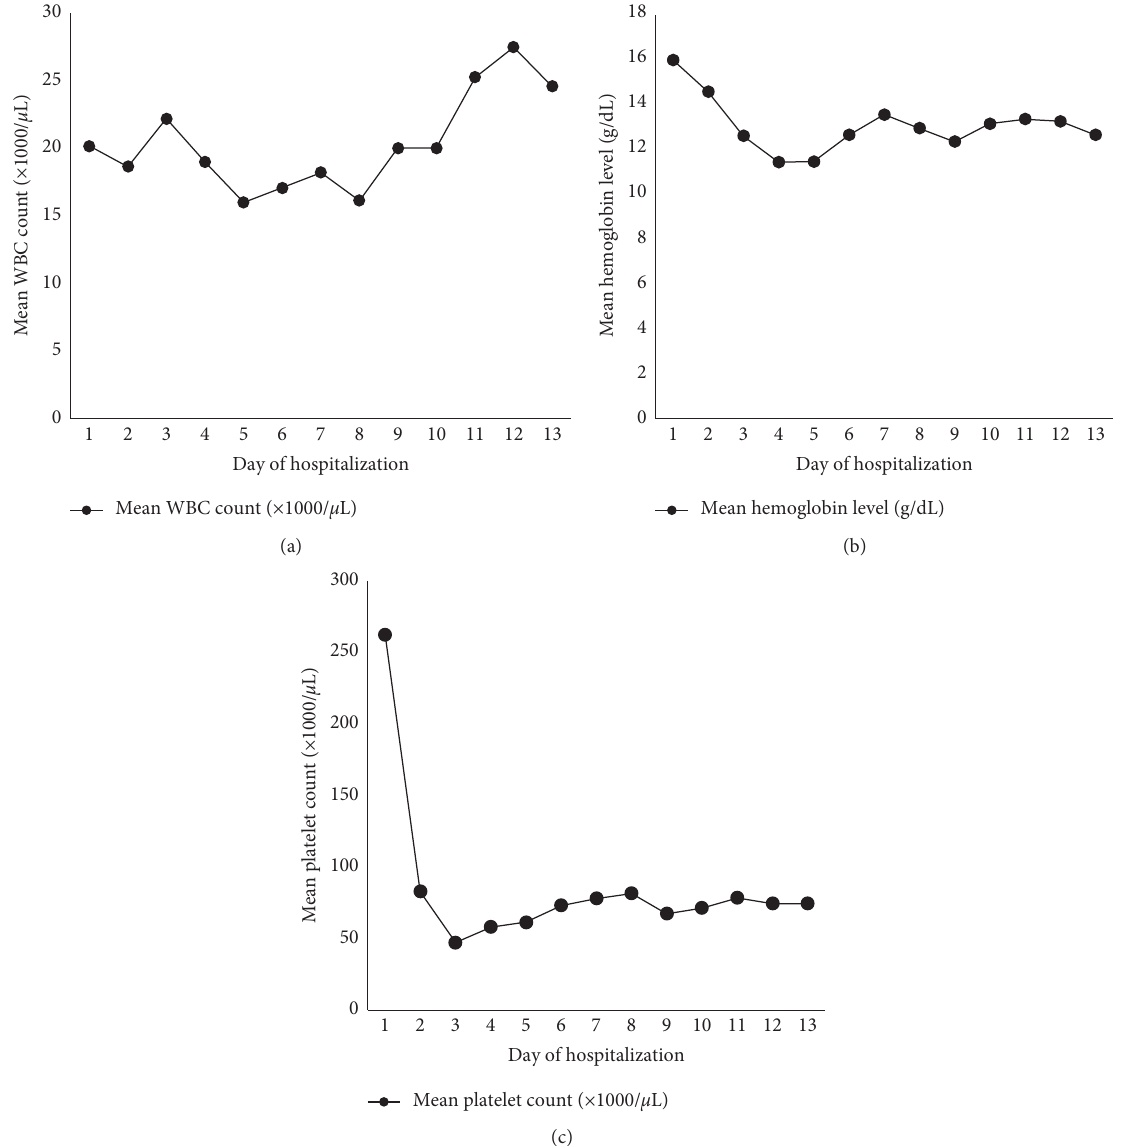
Figure 1: Graphs showing the variation of the mean count of each bone marrow lineage as a function of time. (a) Mean white blood cell count ( × 1000 cells/ μ L) over time. Leukocytosis was noted since admission with no significant drop in white blood cell count observed during hospitalization. (b) Variation of mean hemoglobin level (g/dL) over time with acute drop in hemoglobin level observed within 3 days of admission. (c) Variation of mean platelet count ( × 1000 platelets/ μ L) over time showing a significant decrease of platelet count within 3 days of